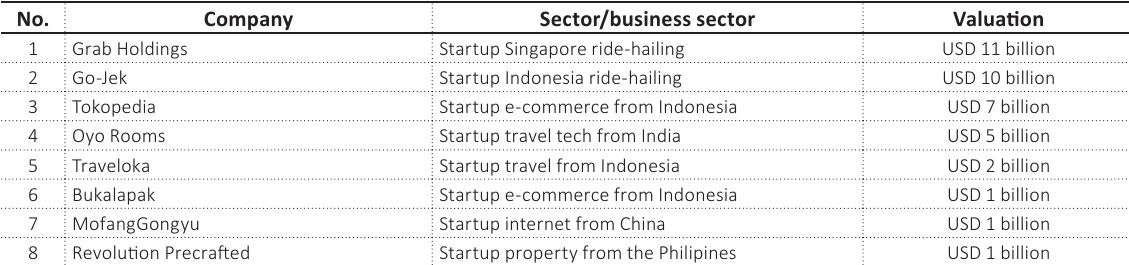
Table 2. List of decacorns and unicorns in Asia